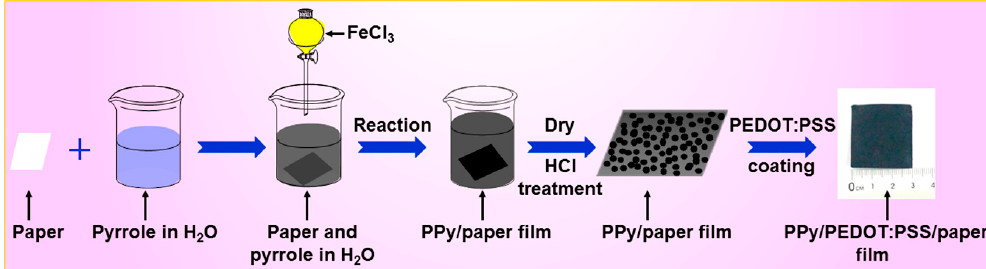
Figure 1. The fabrication process of the PPy/paper and PEDOT:PSS/PPy/paper composite